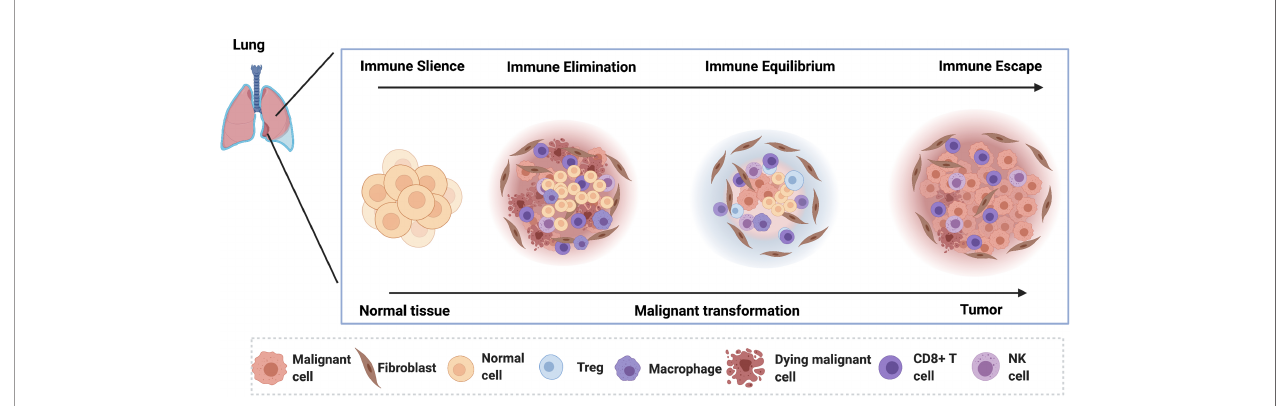
FIGURE 1 | The lung cancer tumorigenesis in the early stage of lung cancer is depicted. In the pre-lesion, the immune cells dominate the microenvironment and eliminate the malignant cells by inducing the cell death. In the immune equilibrium phase, the malignant cells become quiescent under the control of the activated immune cells. As the disease progress, the malignant cells escape the immune surveillance.